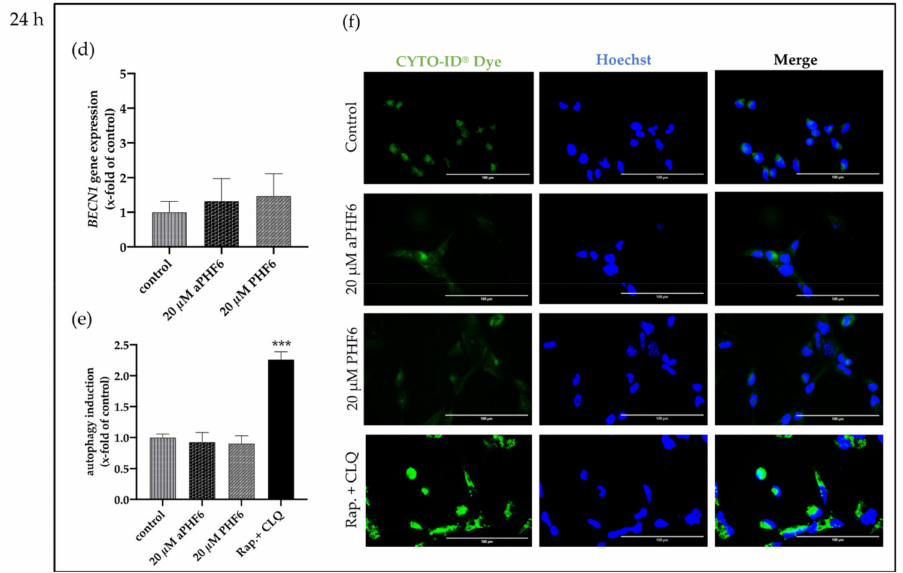
Figure 7. Aggregated PHF6 induced autophagy in HMC3 cells after 6 h. ( a ) Signifi- cantly increased mRNA levels of autophagy marker BECN1 were observed within the 20 µ M aPHF6 treatment group compared to PHF6 or untreated controls as quantified by qRT-PCR. ( b , c ) The autophagy assay confirmed the increased autophagosome formation after aPHF6 treatment by both plate-reader readout and fluorescence image intensity measurement. ( d ) No changes in BECN1 gene expression were observed after 24 h of 20 µ M aPHF6 treat- ment. ( e , f ) The autophagy assay confirmed no difference in autophagy flux among the treat- ment groups. A mixture of rapamycin and chloroquine was used as a positive control.